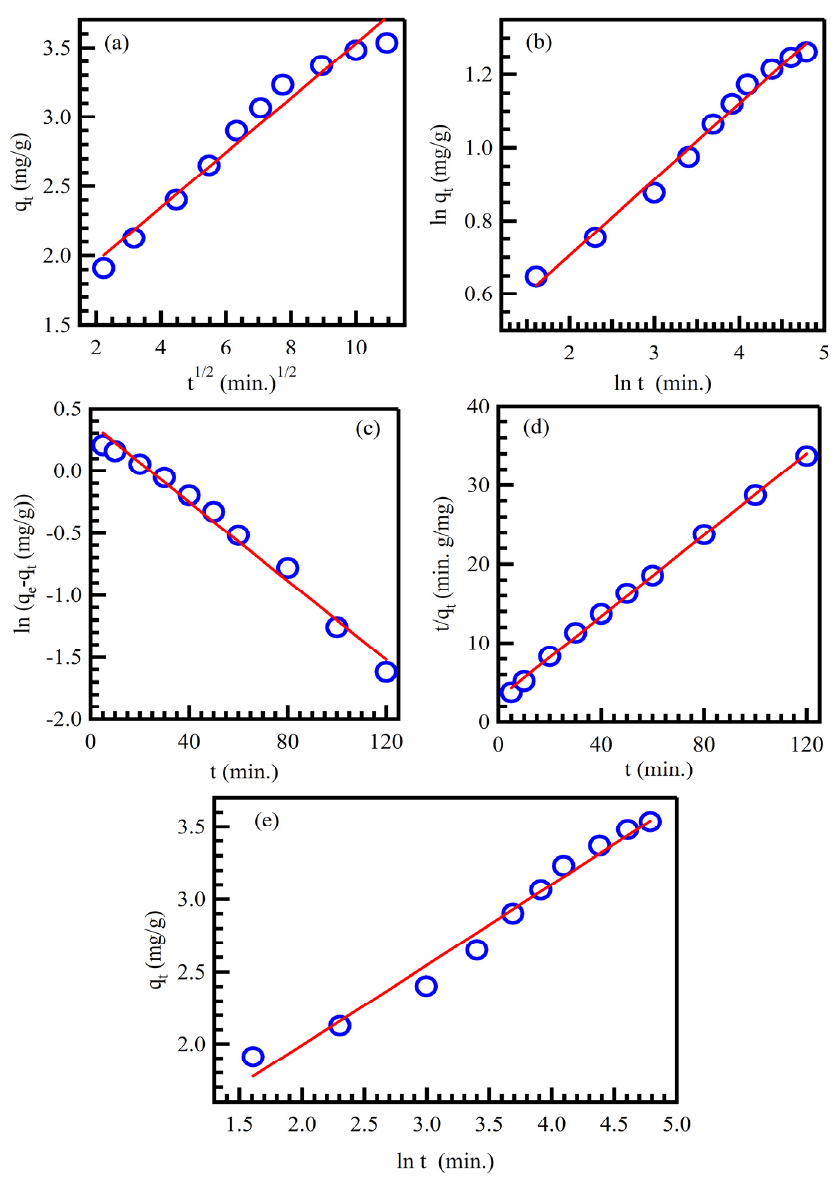
Figure 5. Weber–Morris ( a ), fractional power model ( b ), Lagergren ( c ), pseudo-second-order ( d ), and Elovich model ( e ) plots for Ceph uptake onto HAP.